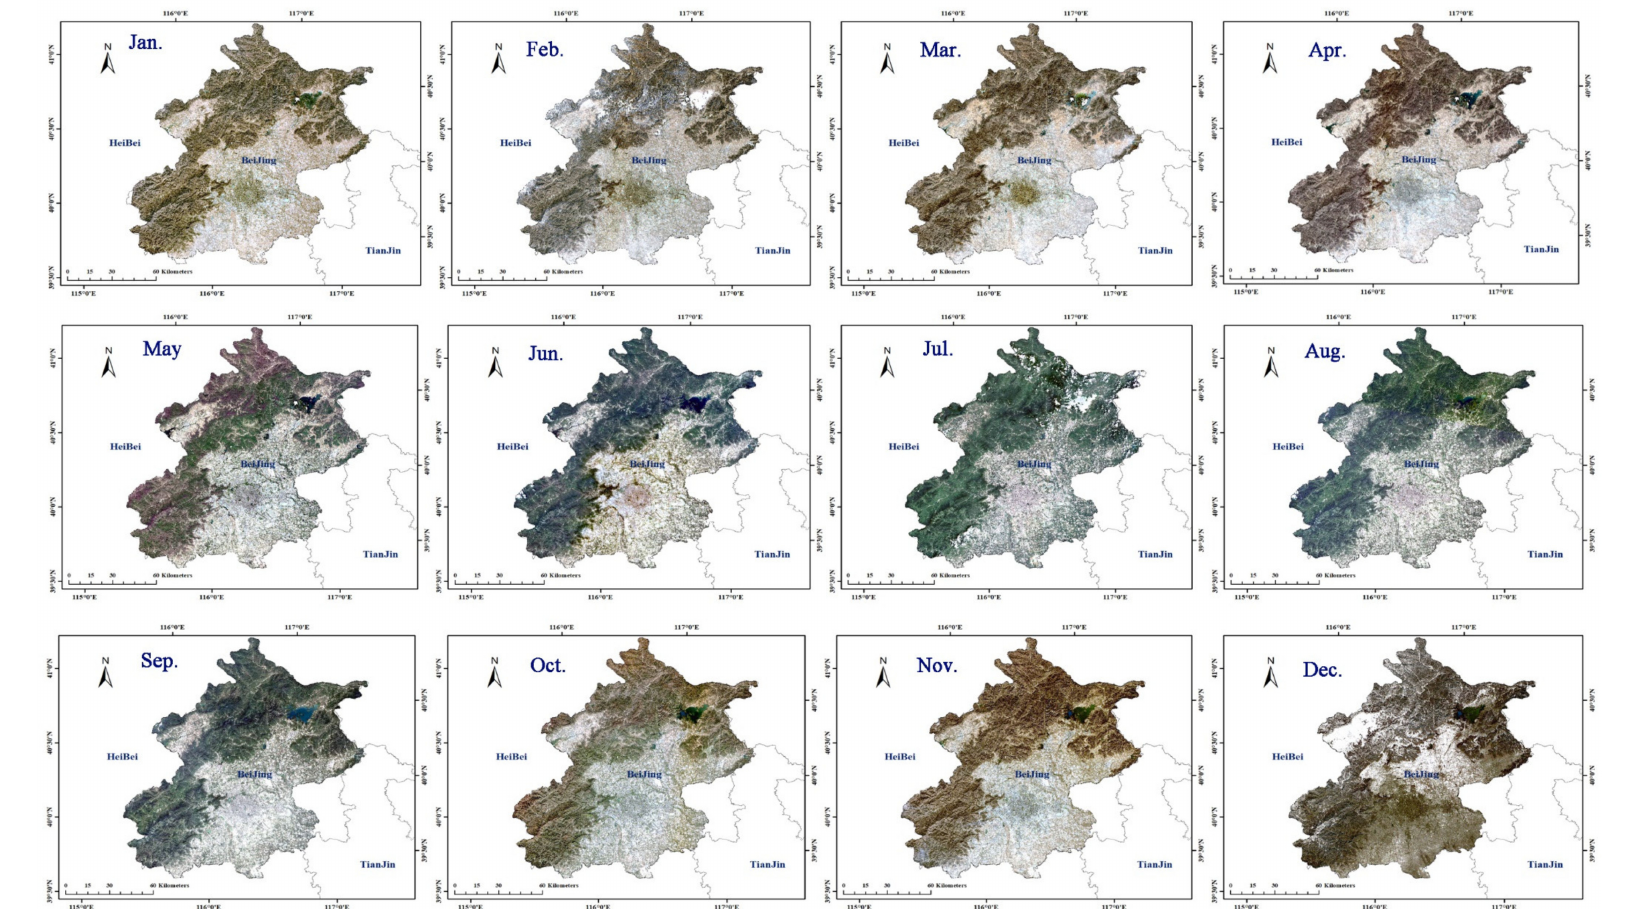
Figure 6. The monthly surface reflectance mosaics in 2019 of Beijing at a closer view from the GF1-WFV